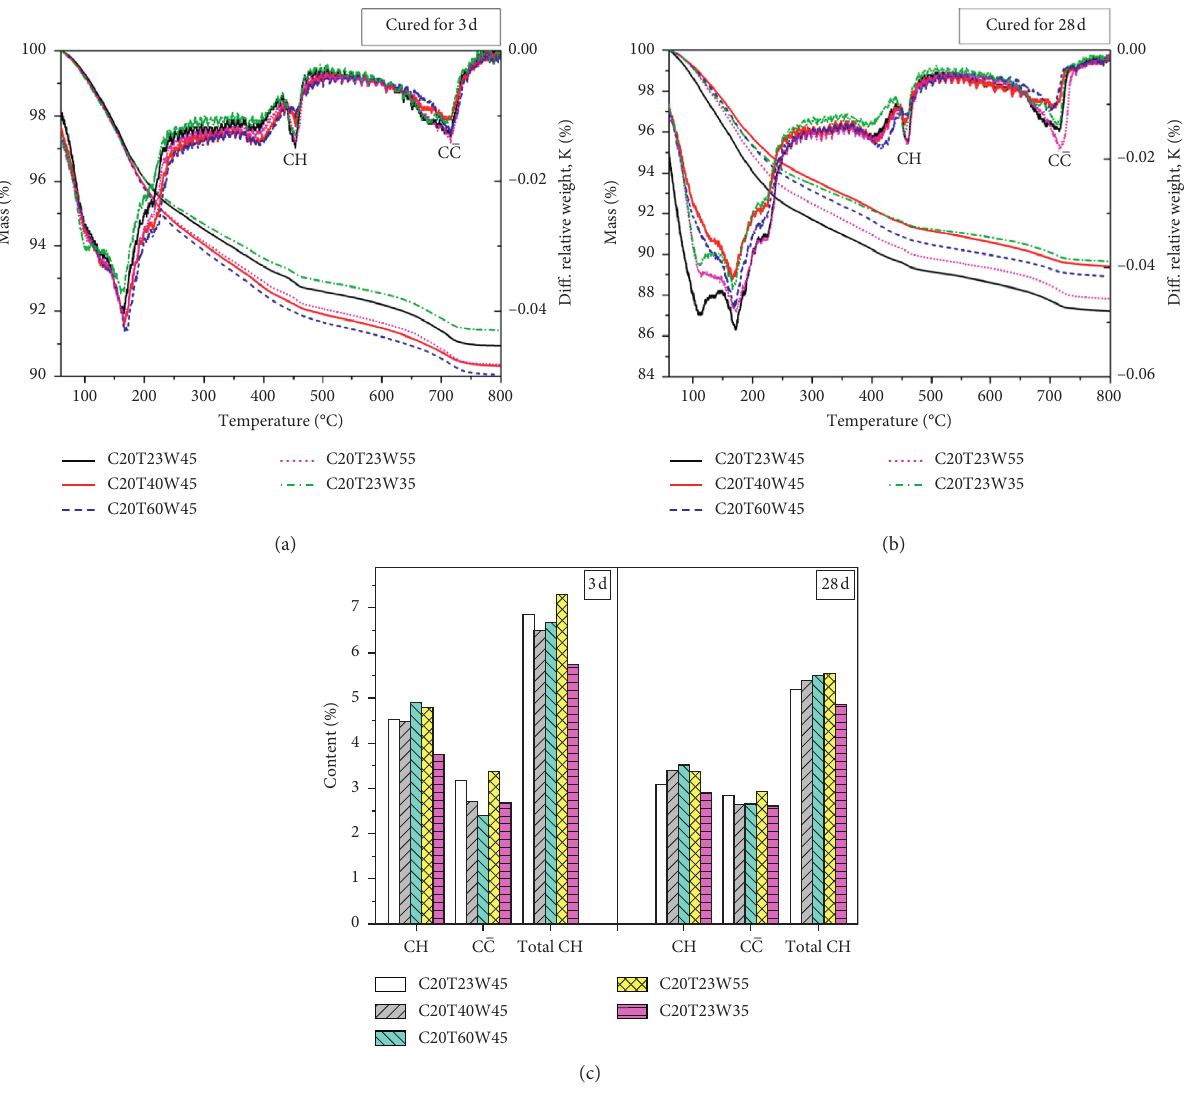
Figure 5: Hydration products of pastes prepared by different curing temperatures and w / b : (a) TGA-DTG results of 3 d pastes; (b) TGA- DTG results of 28d pastes; (c) calculated contents of CH or CC ( — ) or total